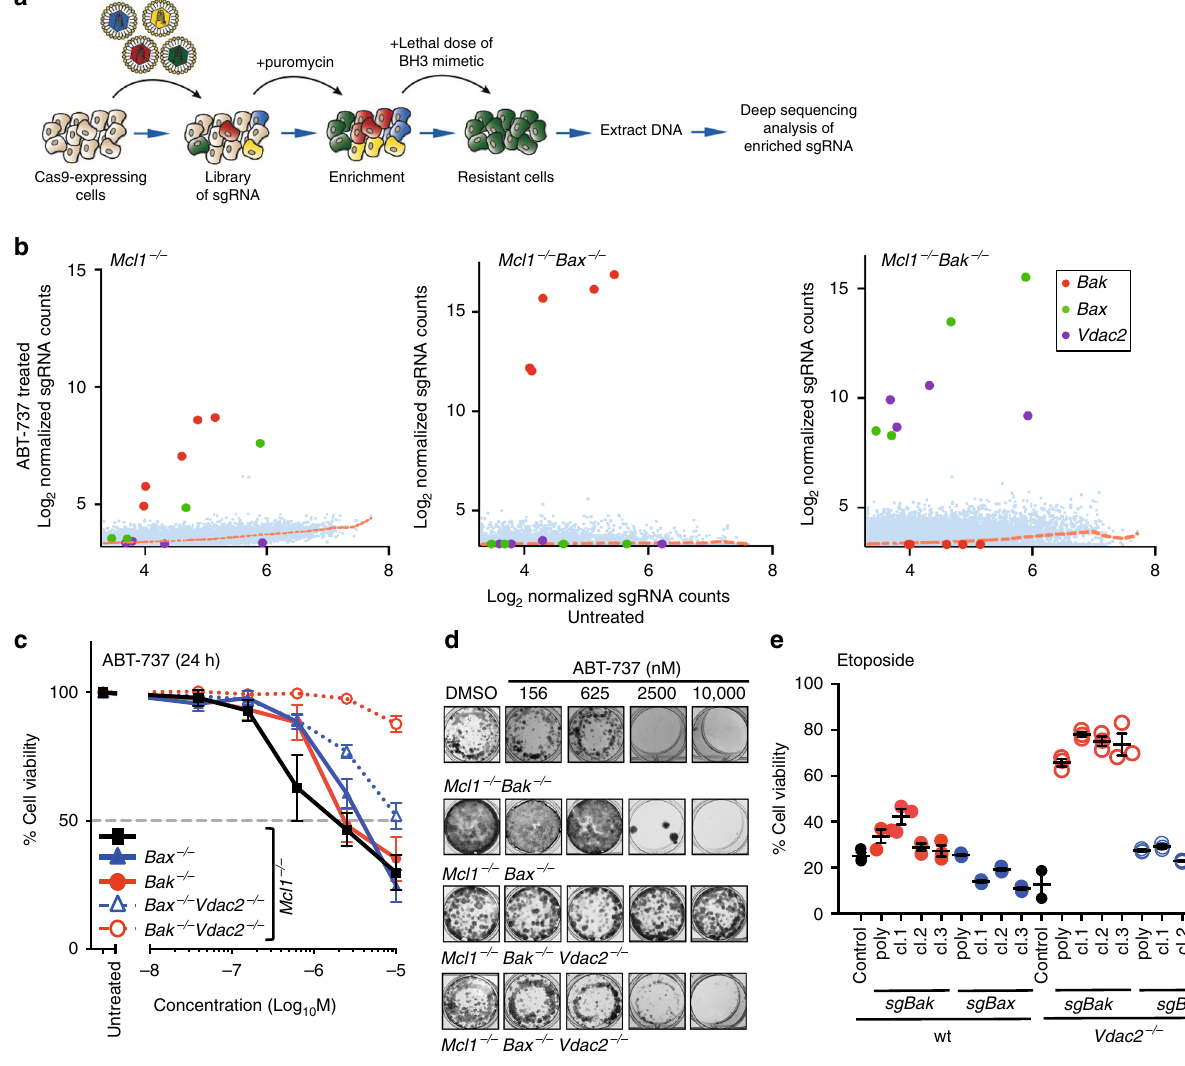
Fig. 1 CRISPR/Cas9 screen identi fi es VDAC2 as a promoter of BAX-mediated apoptosis. a Outline of the genome-wide CRISPR/Cas9 library screens to identify mediators of intrinsic apoptosis. b VDAC2 promotes BAX apoptotic function. MEFs expressing Cas9 and a whole-genome sgRNA library were treated with ABT-737 (LC90, 250 nM, see Supplementary Fig. 1b) for 48 h. Resistant cells were recovered after 5 days and enriched sgRNAs identi fi ed by deep-sequencing. Plots show independent sgRNAs in ABT-737 treated versus untreated controls cells collated and normalized from 2 to 4 independent experiments. Dashed lines represent LOWESS regression curves fi tted to the data. c Deletion of Vdac2 protects from BAX-mediated apoptosis in response to ABT-737. Clones ( Mcl1 − / − Bax − / − Vdac2 − / − and Mcl1 − / − Bak − / − Vdac2 − / − ) or polyclonal populations ( Mcl1 − / − , Bax − / − and, Bak − / − ) of MEFs were treated with escalating doses of ABT-737 for 24 h and cell viability assessed by PI exclusion. Data are mean + / − SEM of at least three independent experiments with 3 – 4 independent clones. d Deletion of Vdac2 provides long-term protection from BAX-mediated cell death. MEFs of the indicated genotype were treated with the indicated concentration of ABT-737 and colony formation was assessed after 5 days. e Deletion of Bak protects Vdac2 − / − MEFs from etoposide-induced apoptosis. Polyclonal populations or three independent MEF clones of the indicated genotype (all on 129sv;C57BL/6 background) were treated with etoposide (10 μ M for 24 h) and cell viability assessed by PI exclusion. Data are mean + / − SEM shown for